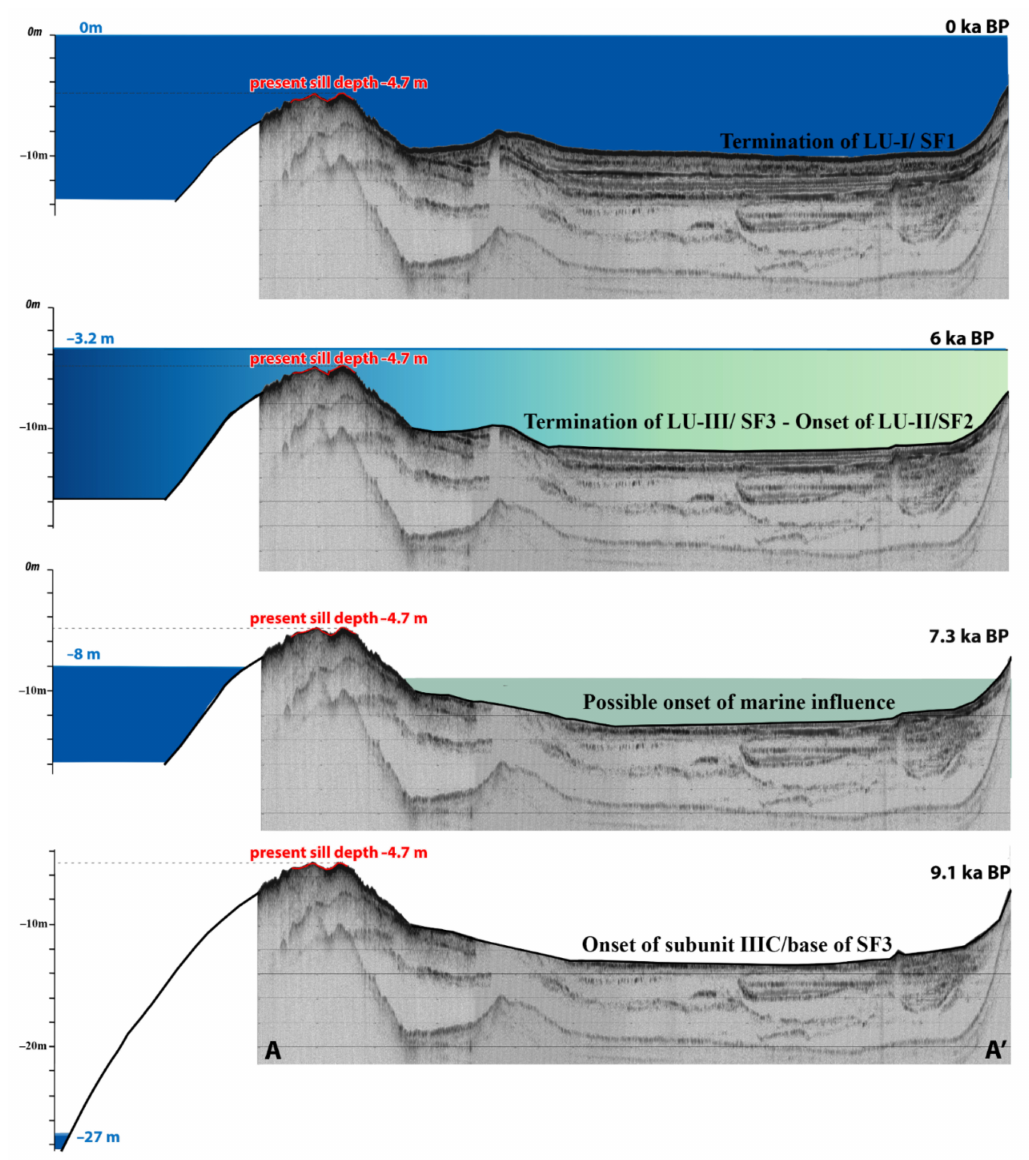
Figure 8. Reconstruction of the different basin phases within the 9.1 ka BP time interval. Each phase represents the lithological unit of the ASTC1 sediment core. Global mean sea level, following Lambeck et al.